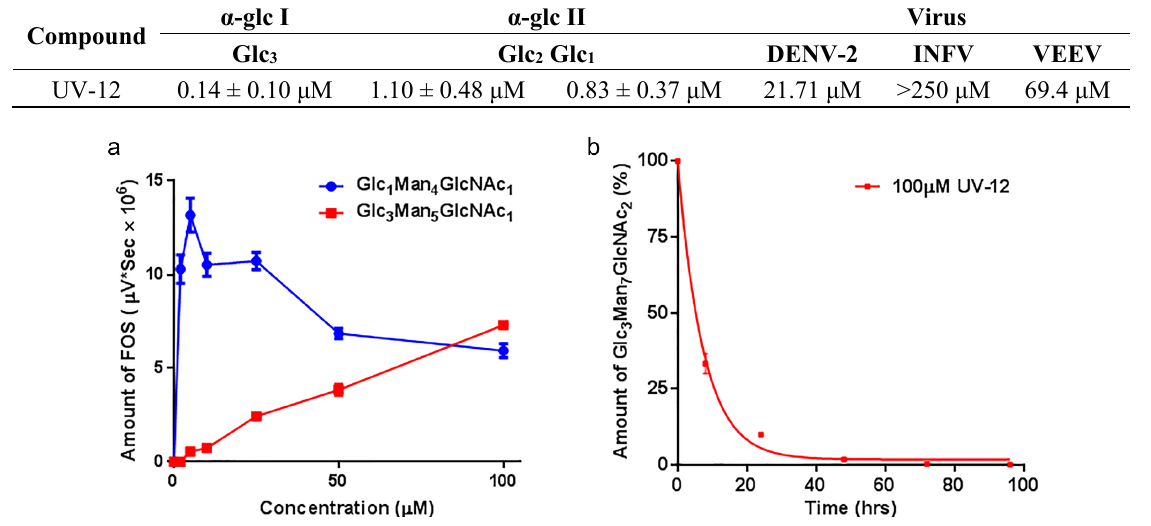
Figure 2. Rates of glucosylated FOS generated in the presence of the α -glucosidase inhibitor UV-12. ( a ) Levels of a monoglucosylated and triglucosylated FOS species generated over a concentration range of UV-12 are shown. The products of glucosidase II inhibition (Glc 1 Man 4 GlcNAc 1 as the exemplar) and glucosidase I inhibition (Glc 3 Man 5 GlcNAc 1 as the exemplar) are indicated; ( b ) Cellular half-life of UV-12 determined based on ER α -glucosidase I inhibition (generation of Glc 3 Man 7 GlcNAc 2 as the readout) are indicated. Fluorescently labeled FOS species were isolated from cells at various times following treatment with 100 μ M UV-12. The mean and SD from triplicate assays is shown in each